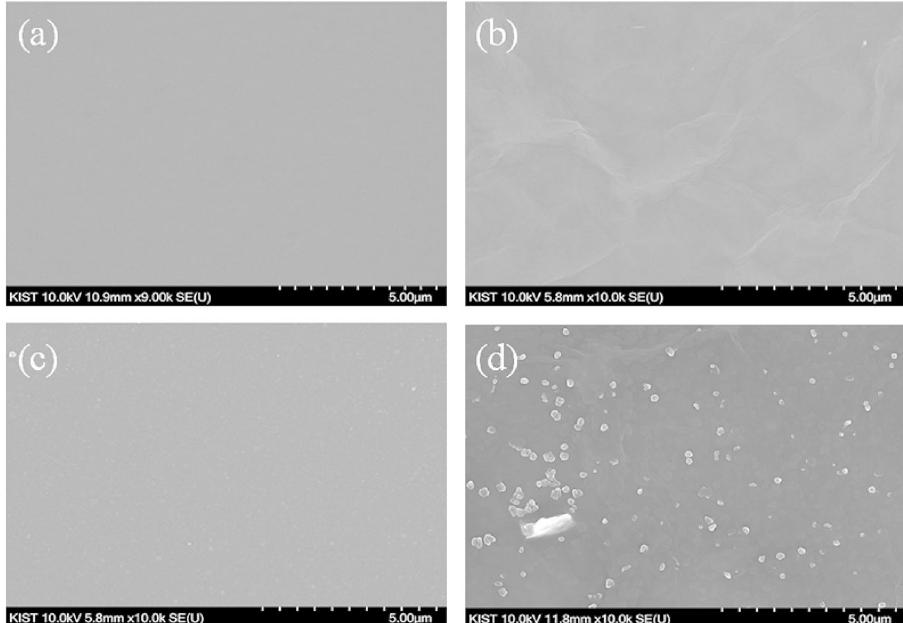
Figure 2. Scanning electron microscopy images of the fabricated ( a ) Au, ( b ) GO, ( c ) PEDOT:PSS, and ( d ) GO/PEDOT:PSS (mixture ratio of 5:1, polymerization time of 300 s) composite. All images display a 10,000 × magnification of the electrode surfaces. The scale bars represent 5